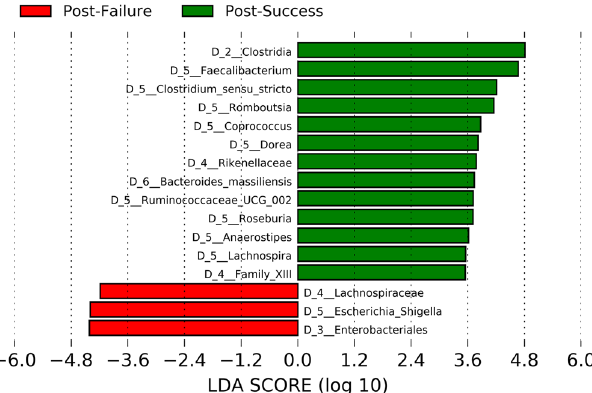
Figure 6. Differences in taxa abundance between responders and non-responders. Taxa with greater differences between the microbiota of both groups. The search for differential taxa was performed using LEfSe (Kruskal– Wallis test between classes, p-value < 0.05; threshold for discriminative taxa, logarithmic LDA score >